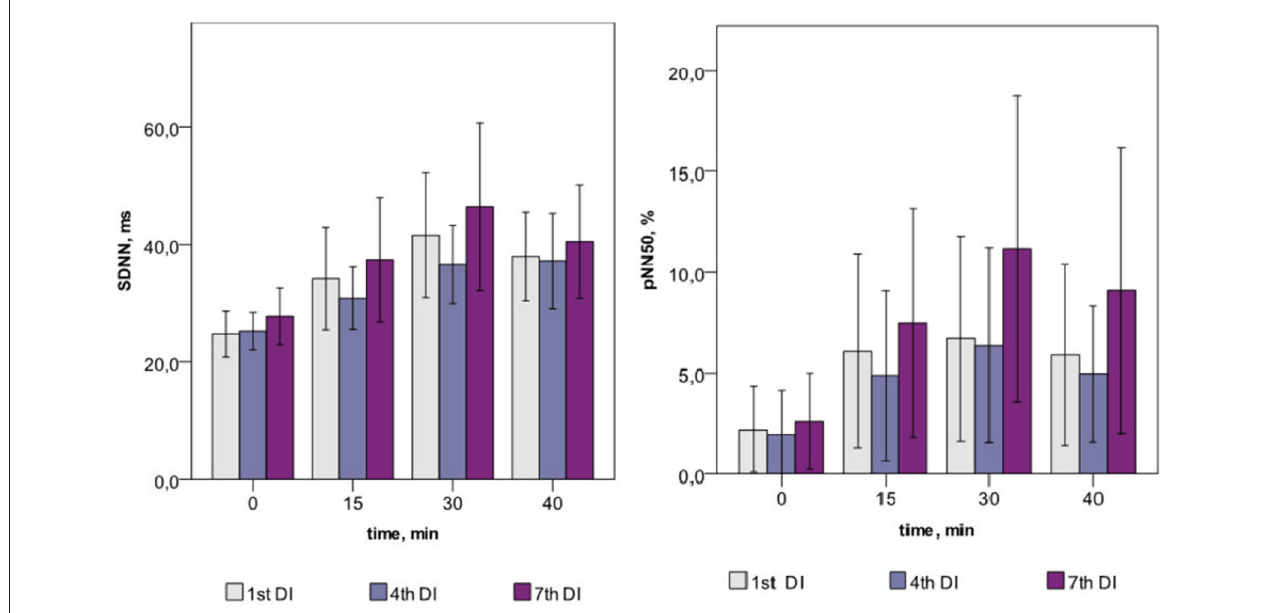
FIGURE 2 | Time-domain HRV parameters in PD patients during repeated “dry” immersion sessions.